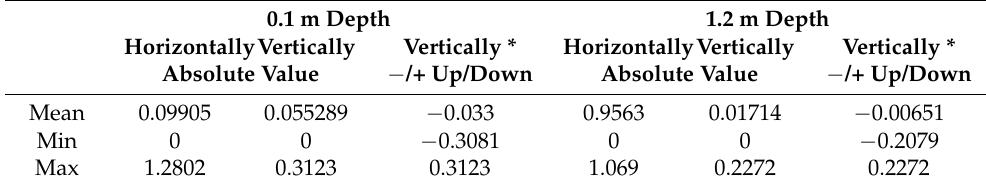
Table 3. Measured current (mixing rates m s − 1 ) in the 300,000 L reactor. * Negative values indicate upward vertical currents while positive values indicate downward currents.